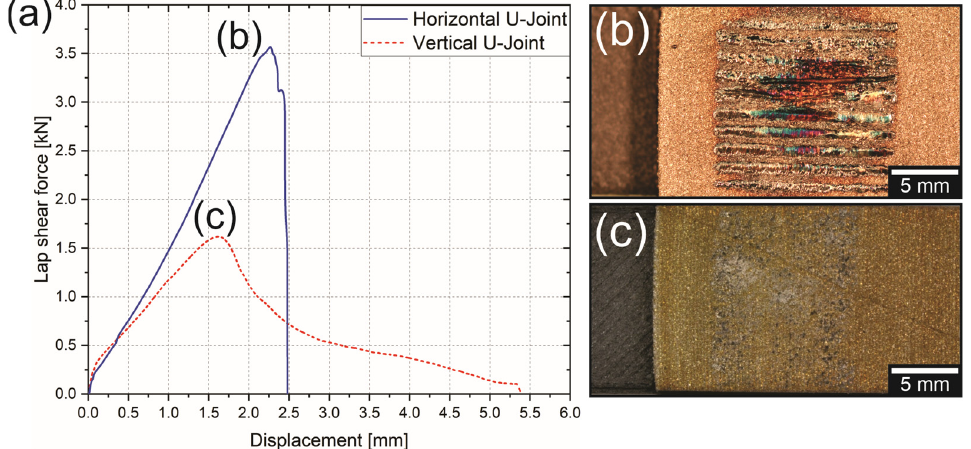
Figure 5. ( a ) Comparison between the mechanical performance of optimized horizontal and vertical U-Joints, and ( b ) and ( c ) show an overview of each of them, respectively. U-Joints, and ( b , c ) show an overview of each of them,